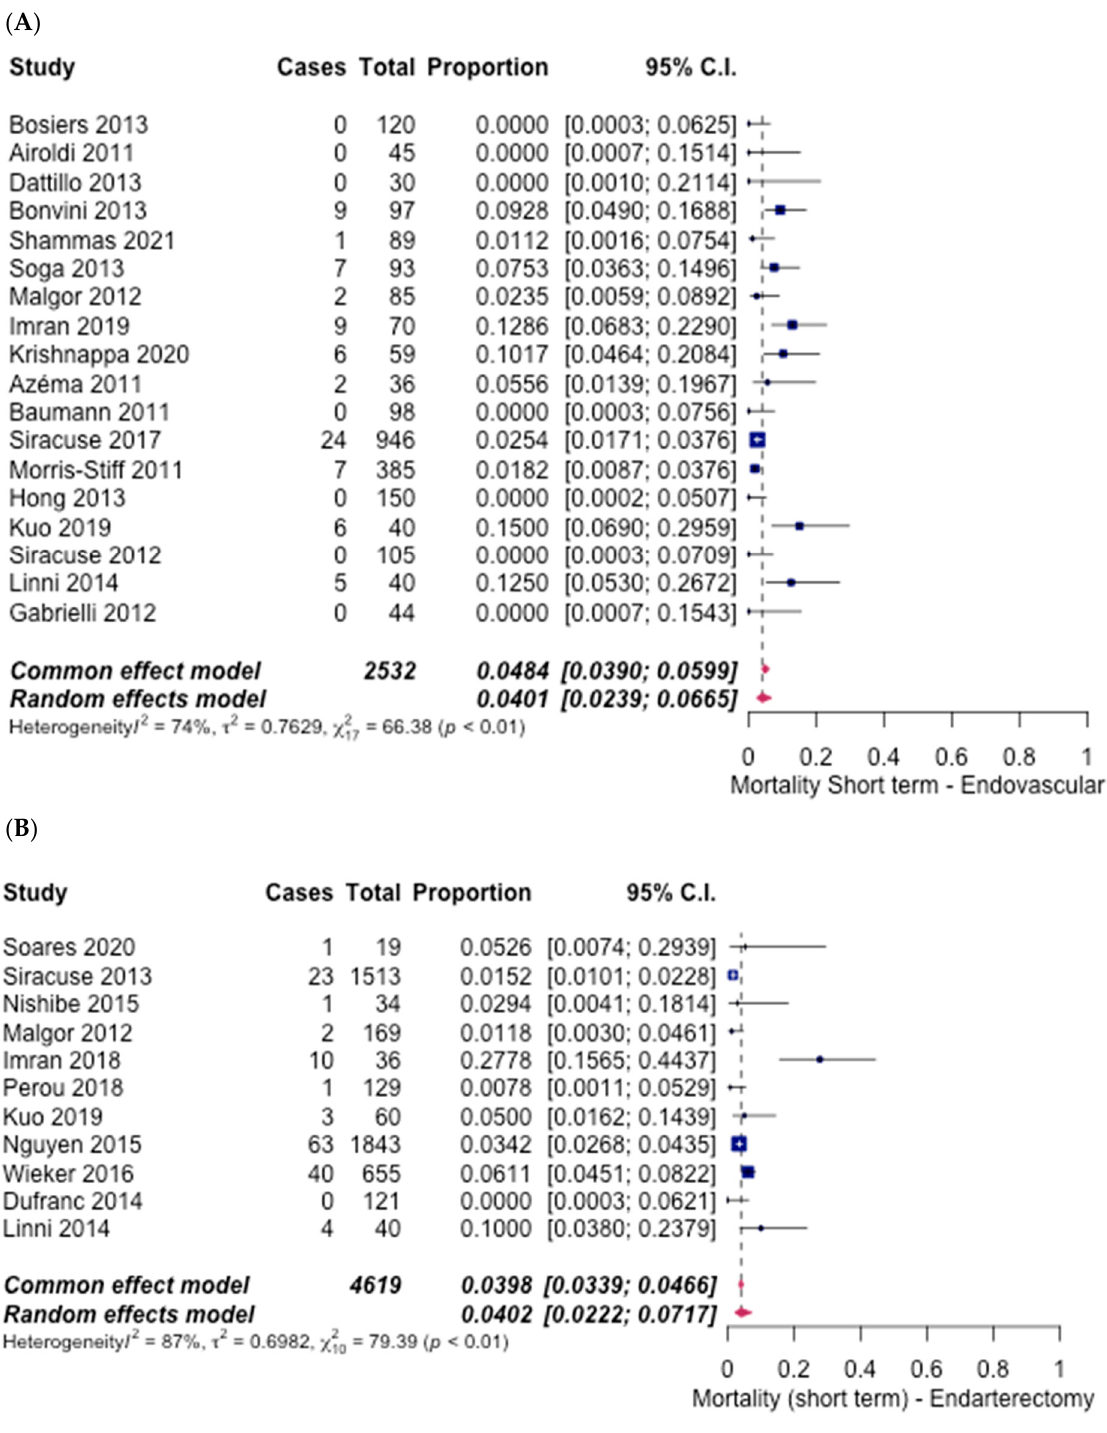
Figure 7. Forest plot for short-term mortality. ( A ) Endovascular intervention [6–22,27]. ( B ) Endarterectomy [6,13,14,21,23–26,28–30]. Similarly, long-term mortality rates from all studies showed no significant difference between groups, with an odds ratio of 0.71 (95% CI [0.58 to 1.06], p = 0.63). The ET group had 13 studies [6,8–12,16–21,27], with a total of 13.03% (95% CI [8.65%, 19.16%]) (Figure 8A) experiencing long-term mortality. Six studies [6,23–26,28] in the FAE group reported an overall rate of 17.42% (95% CI [9.05%, 30.88%]) (Figure 8B).